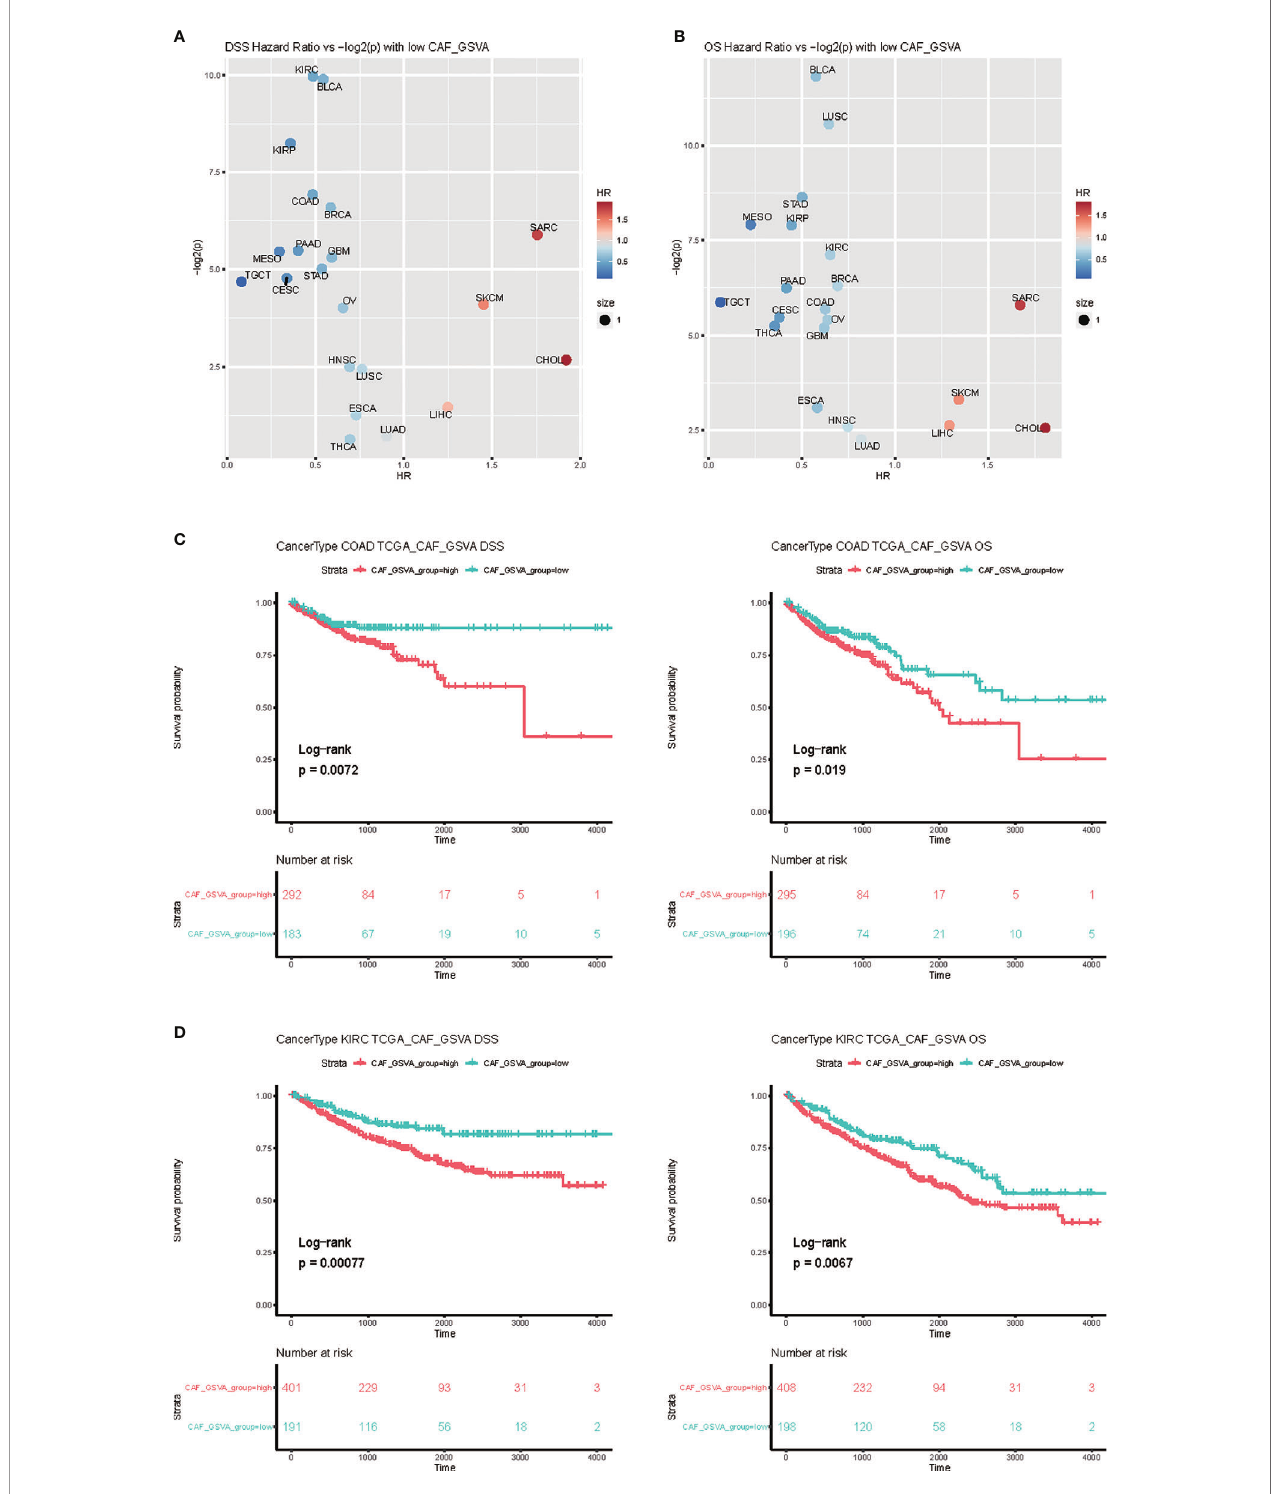
FIGURE 7 | Survival analysis of CAF related genes. (A) Select each 50 genes ( Supplementary Table 1 ) related to the patient ’ s CAF, and use GSVA to calculate the degree of enrichment in TCGA patients. Use this index to classify patients in different tumors and perform survival analysis. (B) The volcano graph of HR and p values, with Overall survival (OS) on the left and disease-speci fi c survival (DSS) on the right. (C, D) Survival analysis of Kidney renal clear cell carcinoma (KIRC) and Colon Adenocarcinoma